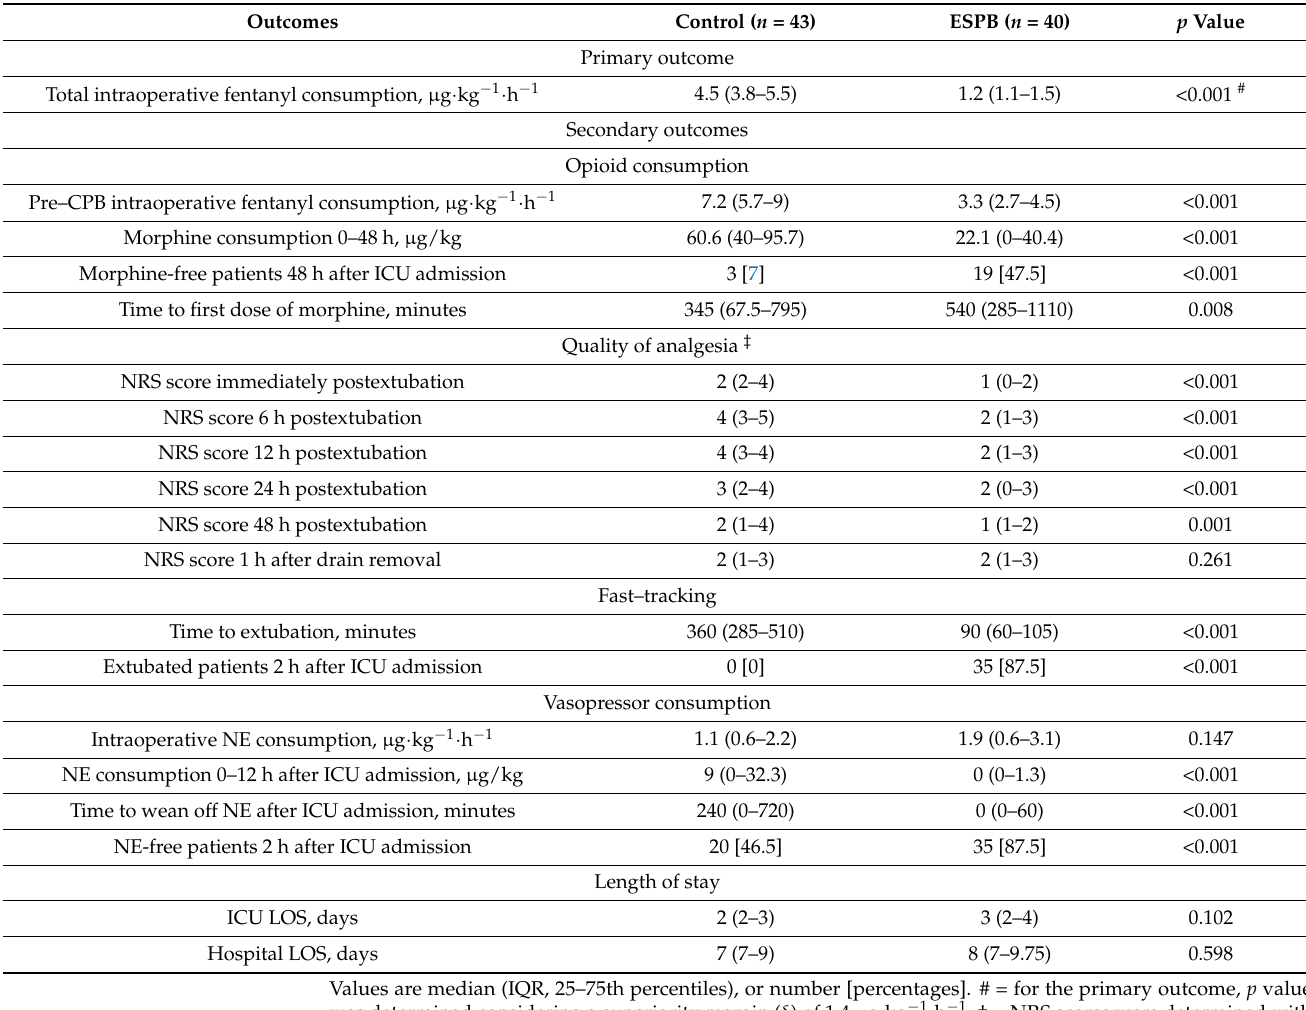
Table 2. Intergroup comparison for the primary and secondary